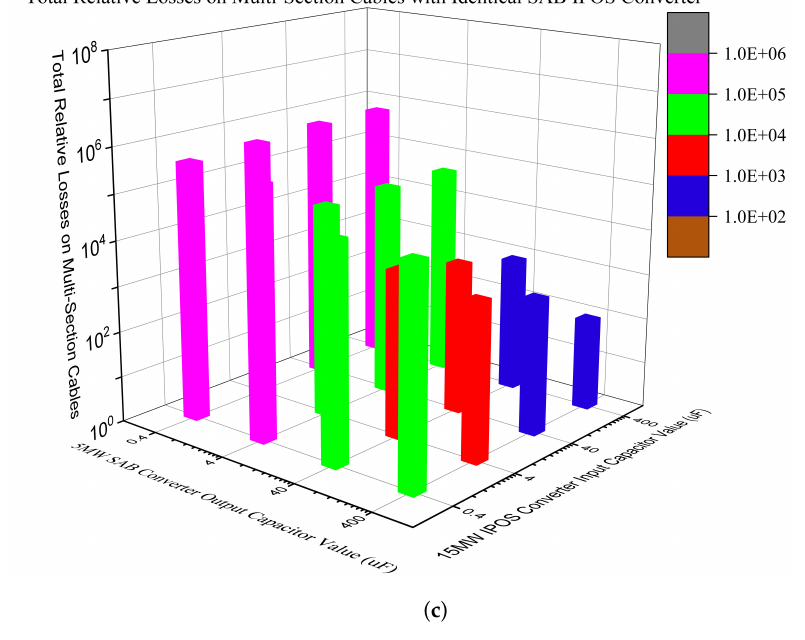
Figure 8. Total relative AC losses on multi-section cables with three different IPOS converter struc- tures. ( a ) Total relative AC losses on multi-section cables with SAB+Three Phase IPOS Converter; ( b ) total relative AC losses on multi-section cables with identical Three Phase IPOS Converter; and ( c ) total relative AC losses on multi-section cables with Identical SAB IPOS Converter.